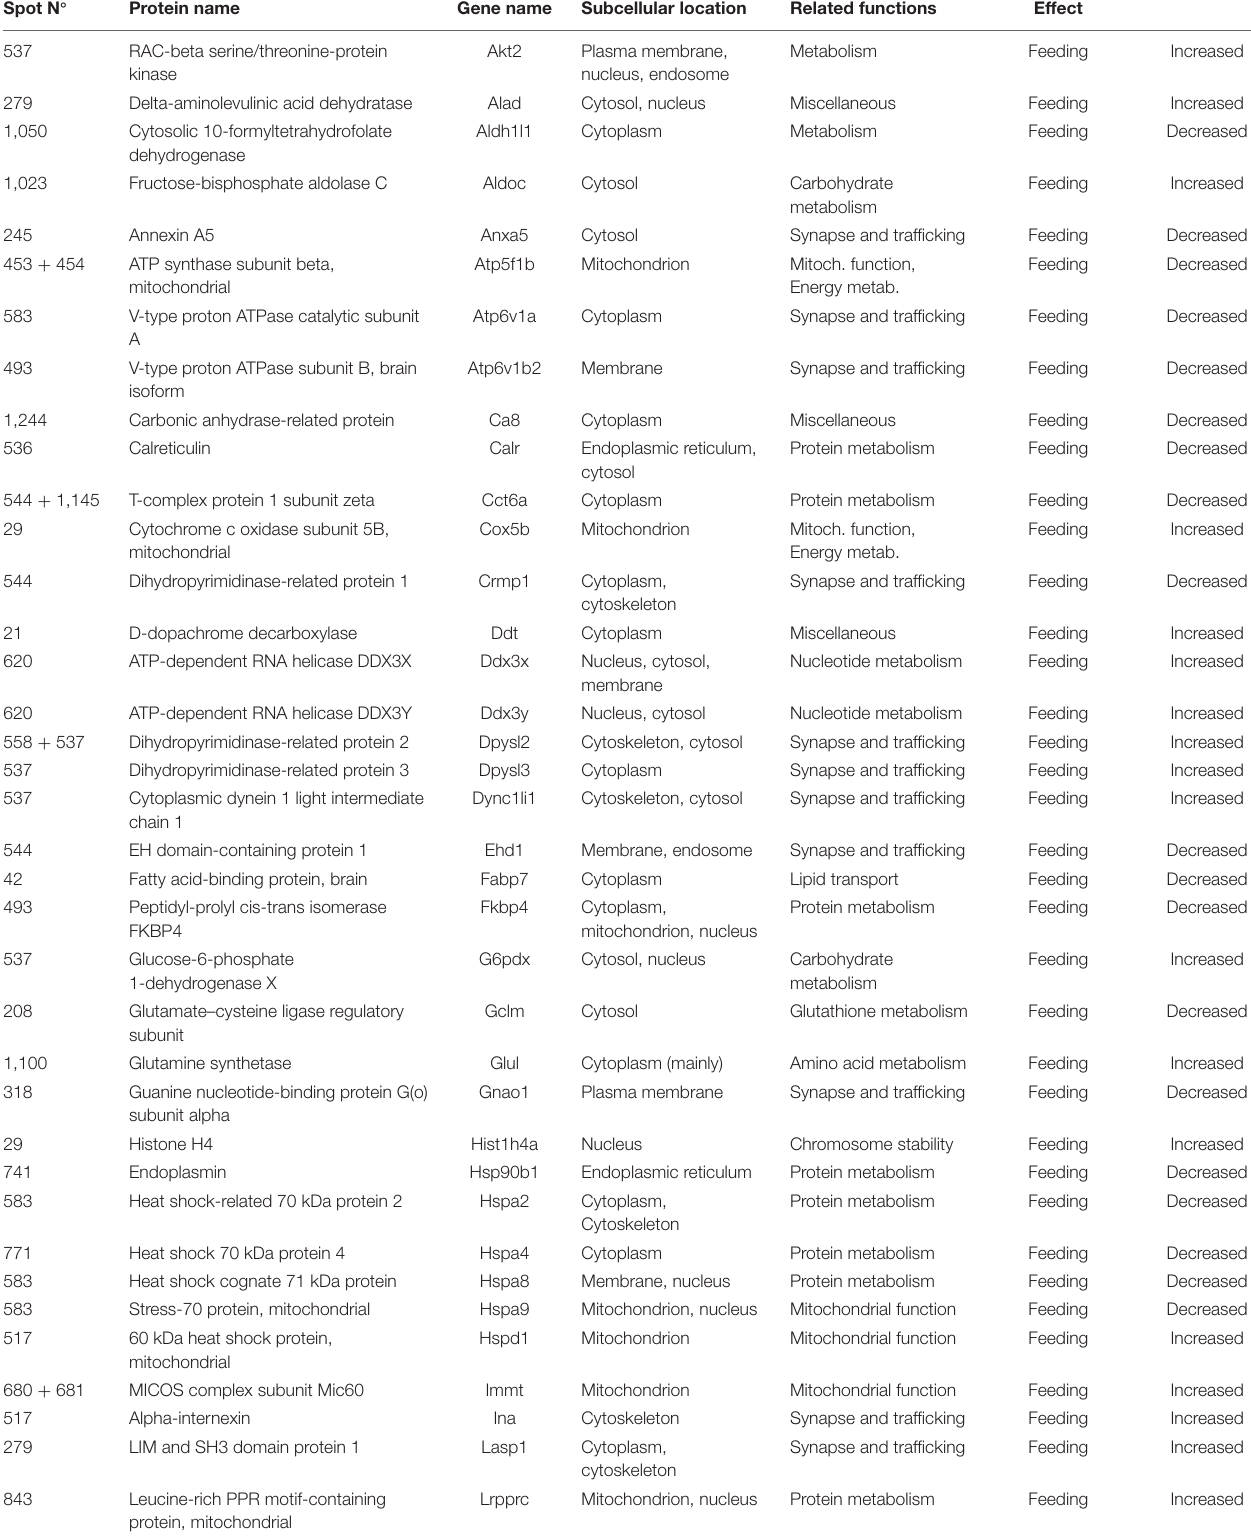
TABLE 1 | List of cerebellar proteins differentially expressed according to feeding conditions and/or time-of-day. Spot N